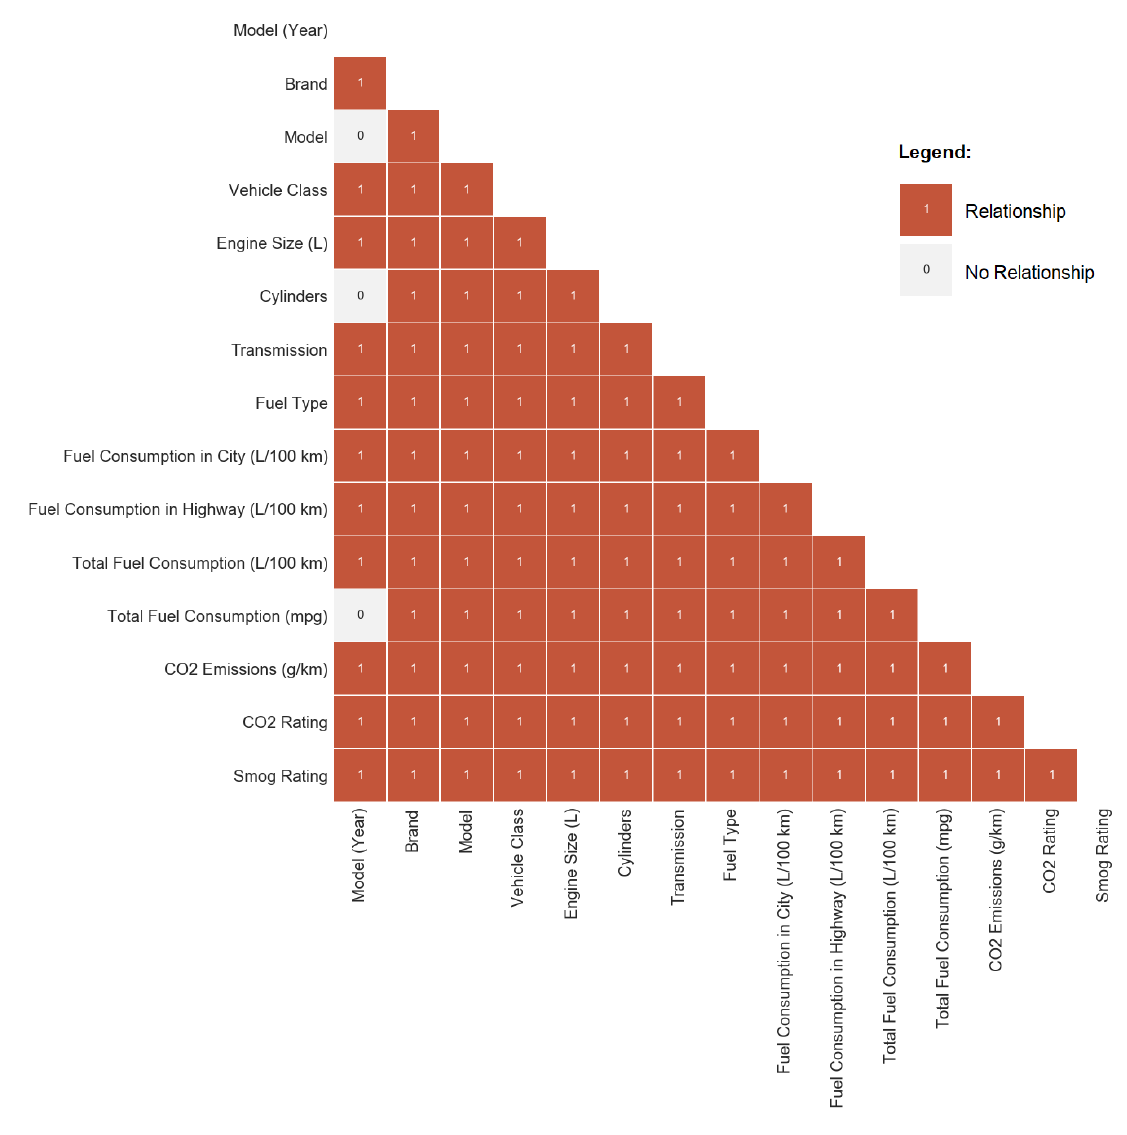
Figure 15. Heat map for Chi-square of Independence tests between all